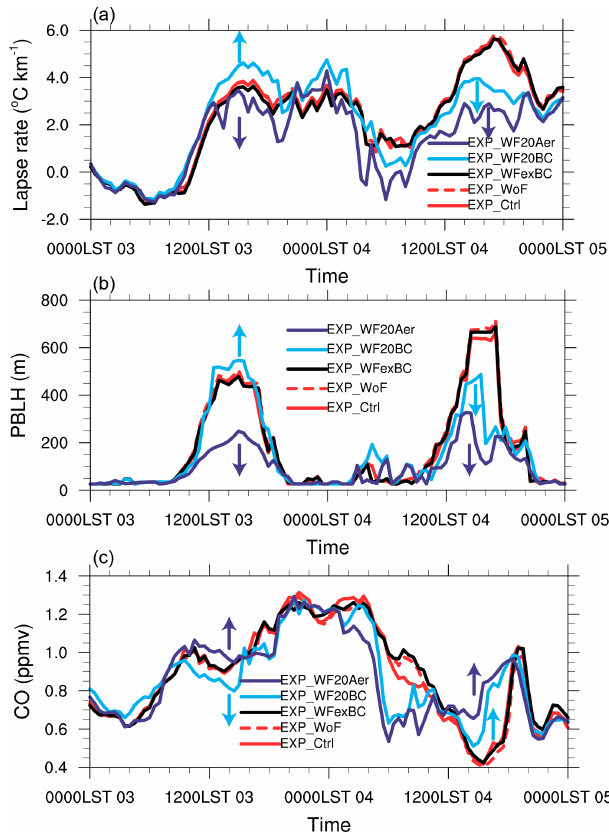
Figure 10. Temporal evolution of the (a) lapse rate within 1.5km, (b) the planetary boundary layer height (PBLH), and (c) the surface CO concentration simulated by the five parallel exper- iments. The upward or downward arrows indicate an increase or decrease compared to the EXP_Ctrl.